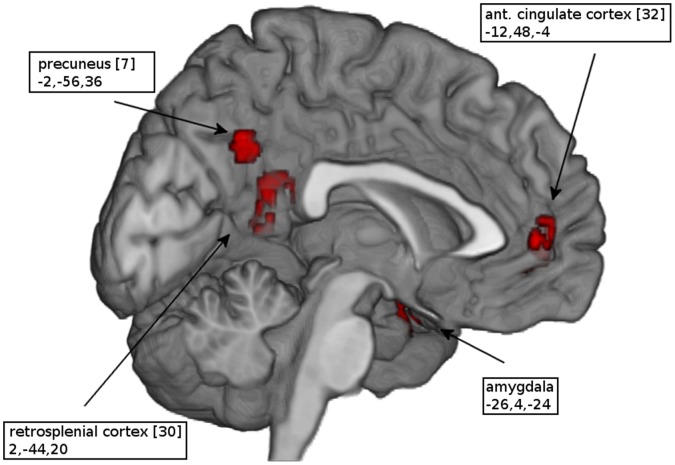
Activation map of patients.Significant activations of PTSD patients in response to trauma-related stimuli as compared to a neutral condition. (Numbers in brackets indicate Brodmann areas and coordinates of the peak voxel are in Talairach space).